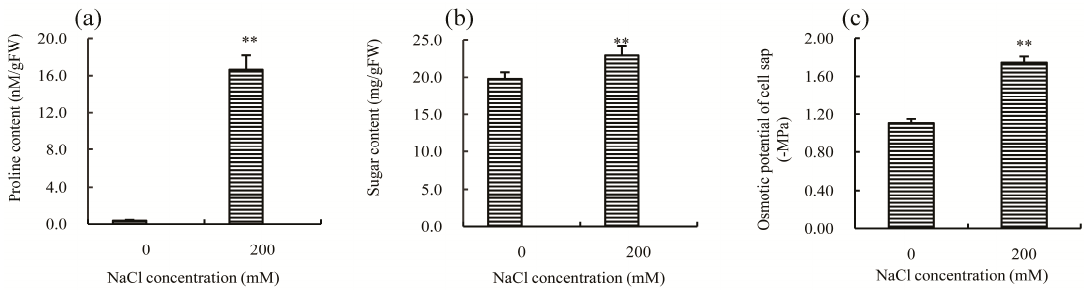
Figure 3. Effects of 200 mM NaCl stress on the: proline ( a ); and soluble sugar ( b ) concentrations; and the osmotic potential ( c ), in the leaves of Chinese cabbage seedlings. All parameters were measured on the Day 30 after salt treatment. The values are the means ( ± SD) of five replicates. ** Indicate p < 0.01.